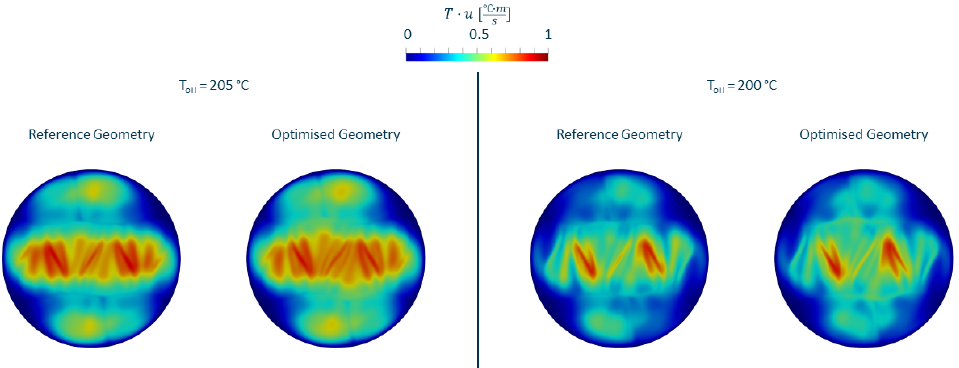
Figure 10. Temperature profile behind the mixer scaled for velocity for reference geometry and geometry optimised for pressure loss for an oil temperature 5 ◦ C above melt temperature ( left ) and at melt temperature ( right